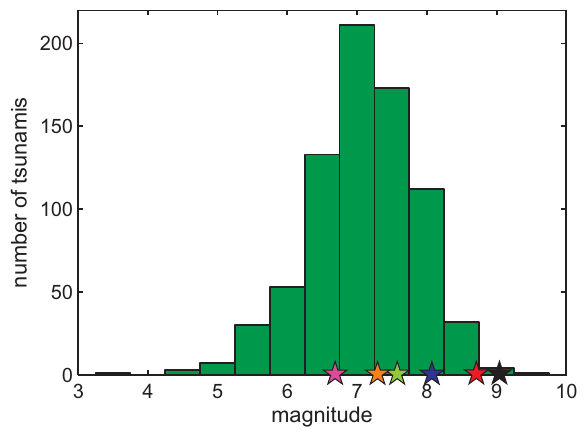
Fig. 4. Histogram of magnitudes for historical earthquakes world- wide that caused a tsunami within the period 1900–2008 based on events listed in the NGDC database ( National Geophysical Data Center, 2009). The colored stars correspond to the events listed in Table 2 and their detection probability functions are shown in Fig. 9.